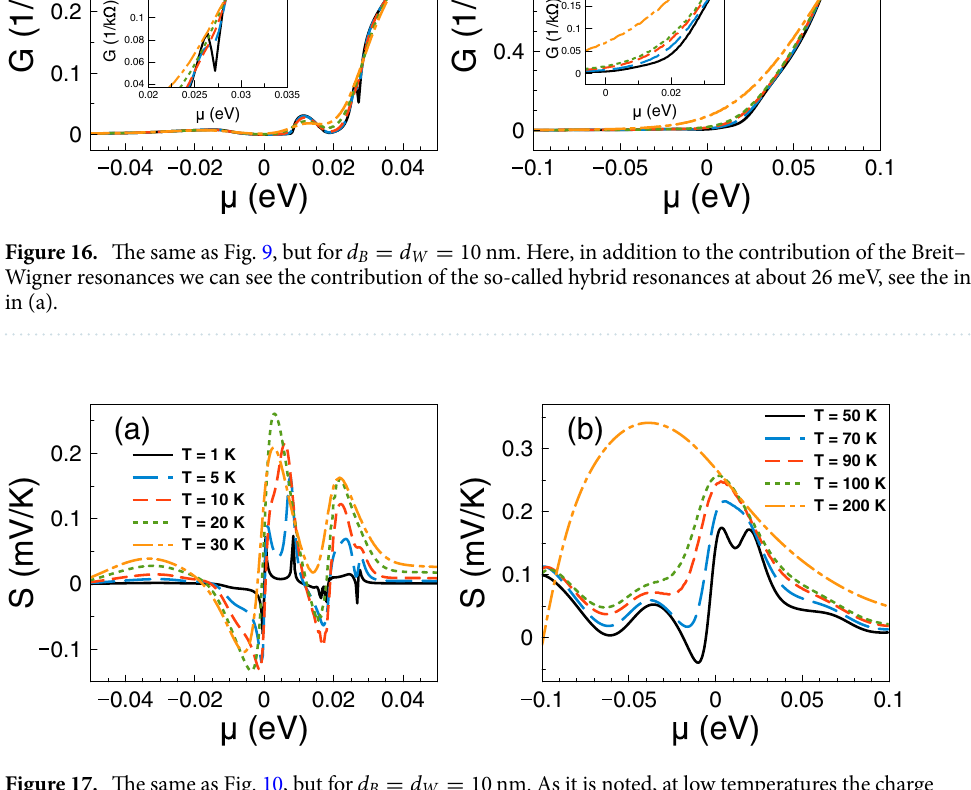
Figure 17. The same as Fig. 10, but for d B = d W = 10 nm. As it is noted, at low temperatures the charge neutrality point and the Breit–Wigner resonances shape the Seebeck coefficient characteristics, while the hybrid resonances become preponderant as the temperature rises, merging with the charge neutrality point and the Breit–Wigner resonances as as single broad peak at high temperatures.